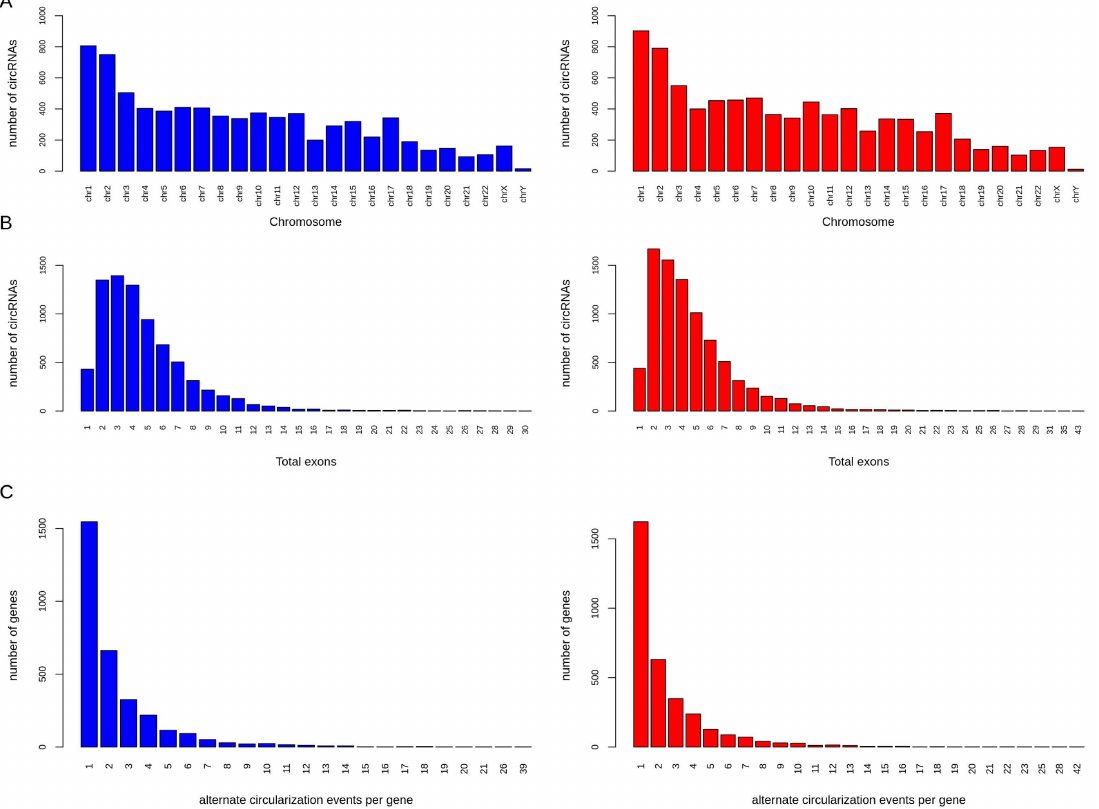
Figure 2. Genomic features of circRNAs in α - and β -cells. The figure shows ( A ) the chromosomal distribution of circRNAs, ( B ) total number of back-spliced exons in circRNAs, and ( C ) number of alternate circularization events per gene in α - (blue) and β - (red) cells.